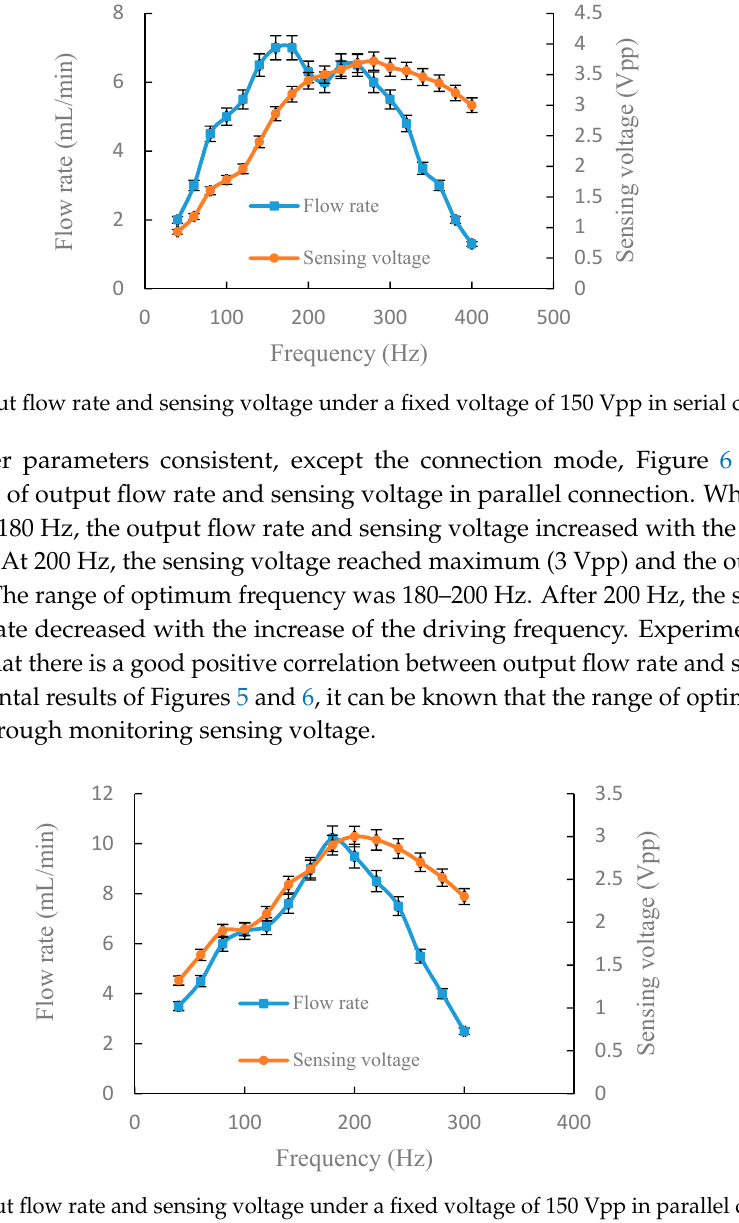
Oscilloscope Figure 4. The schematic of the self-sensing test of the DSPPIS. 4. Experimental Results and Discussion For the accuracy and authenticity of the data, we repeated the following experiment three times for each group. The relative standard deviation of the measured data was calculated and is indicated as error bars in Figures 5 – 8. Figure 5 shows the experimental results of the output flow rate and the sensing voltage under